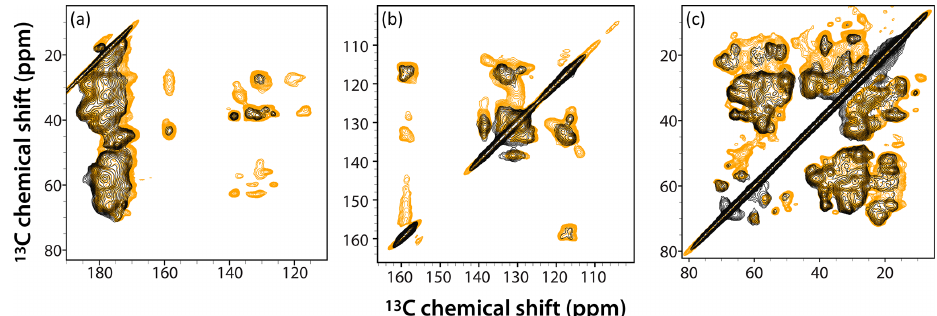
Figure 6. Superposition of DNP-enhanced CP-CORD spectra of 5F-Trp, U- 13 C, 15 N tubular CA assemblies in the presence of 4.3mM AMUPol (gold) and 28.2mM AMUPol (black). Expanded regions of the spectra around carbonyl-aliphatic/aromatic-aliphatic (a) , aro- matic (b) , and aliphatic (c) are shown. The recycle delay was 5s and the CORD mixing time was 20ms. The spectra were acquired at 14.1T (150.96MHz 13 C Larmor frequency) at a MAS frequency of 24kHz and 120K sample